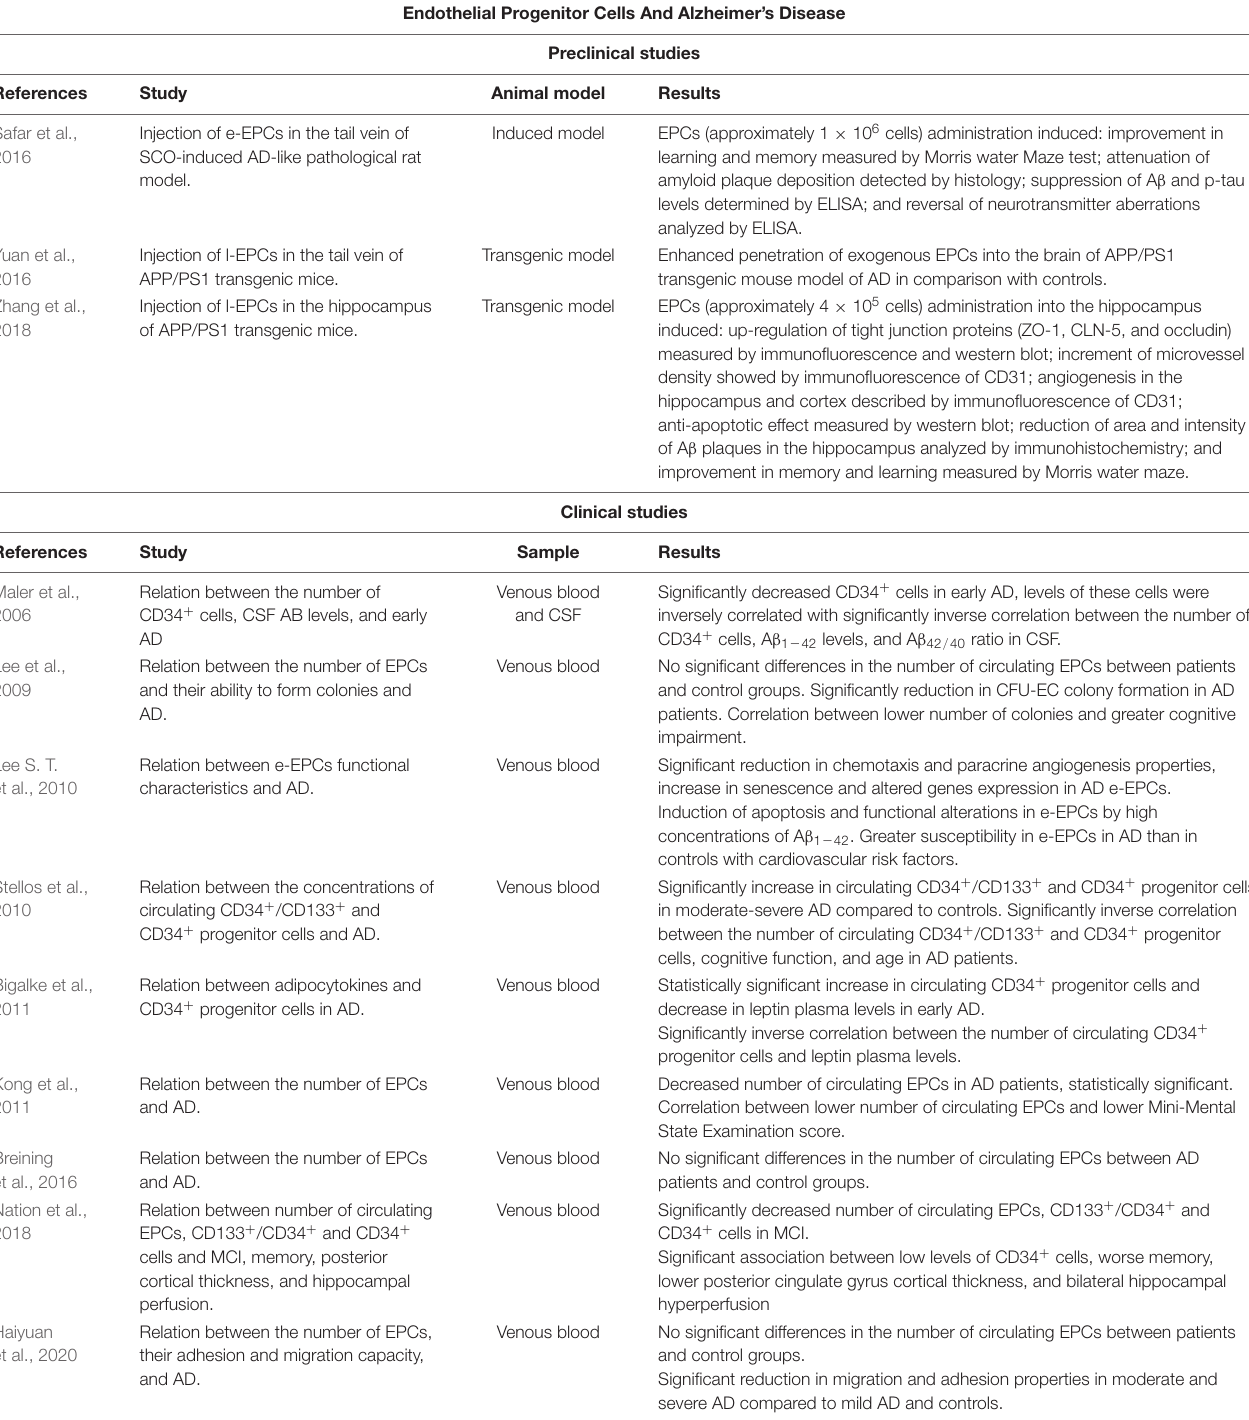
TABLE 1 | Summary of relevant preclinical and clinical studies on association between EPCs and